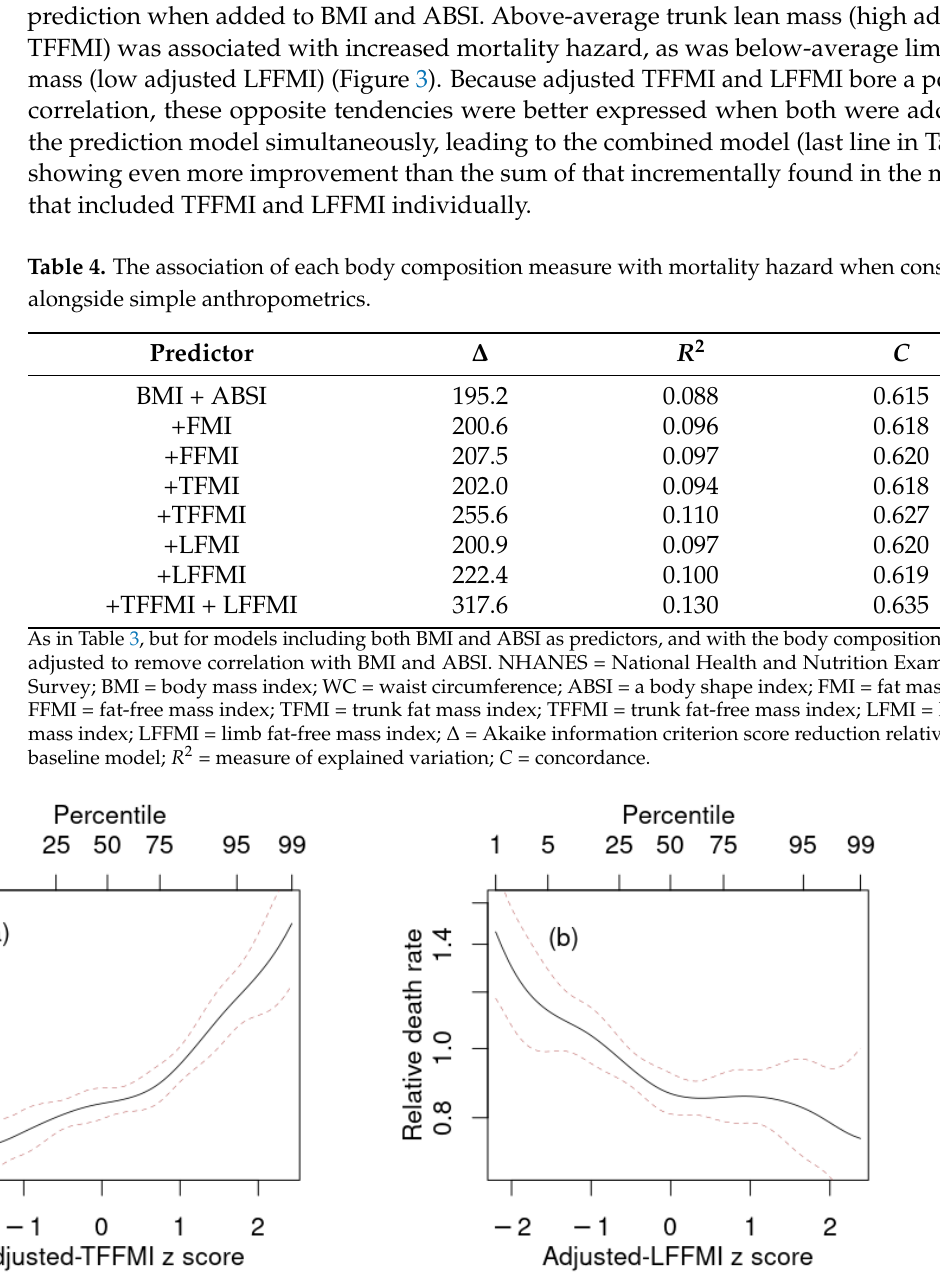
Figure 3. Estimated mortality hazard ratios in NHANES 1999–2006 as nonlinear (penalized spline) functions of adjusted ( a ) TFFMI, ( b ) LFFMI in models that also include as predictors BMI and ABSI. Dashed lines indicate 95% confidence intervals. NHANES = National Health and Nutrition Examination Survey; BMI = body mass index; ABSI = a body shape index; FMI = fat mass index; TFFMI = trunk fat-free mass index; LFFMI = limb fat-free mass